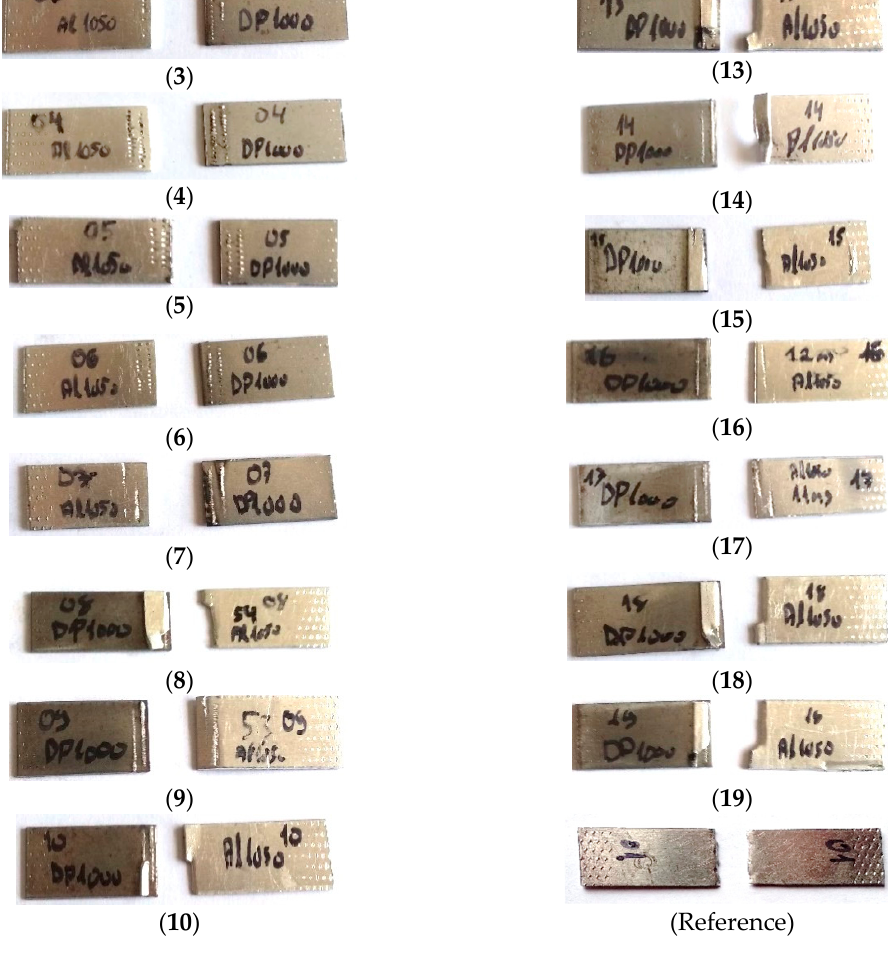
Figure 10. Samples after tensile testing.